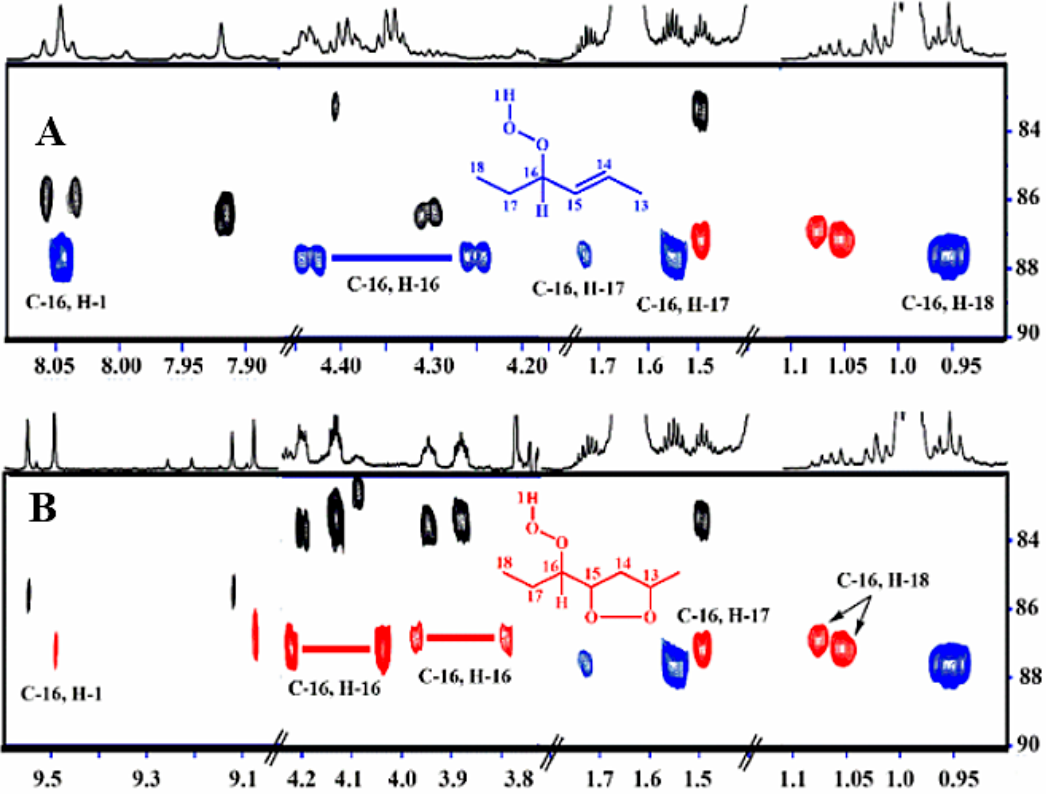
Figure 3. Selected regions of 800 MHz 1 H- 13 C HMBC NMR spectrum of 20 mg methyl linolenate in CDCl 3 , subjected to heating at 40 °C for 48 h, number of scans = 32, number of increments 256, total experimental time = 12 h, T = 298 K. The critical cross-peak connectivities of C-16 with H-1(OOH), H-16 ( 1 J ( 13 C, 1 H)), H-17, and H-18 of the 9- cis , 12- cis, 14- trans -16-OOH hydroperoxide ( A ), and two diastereomeric 9- cis , 11- trans -16-OOH endo -hydroperoxides (in red) ( B ), are